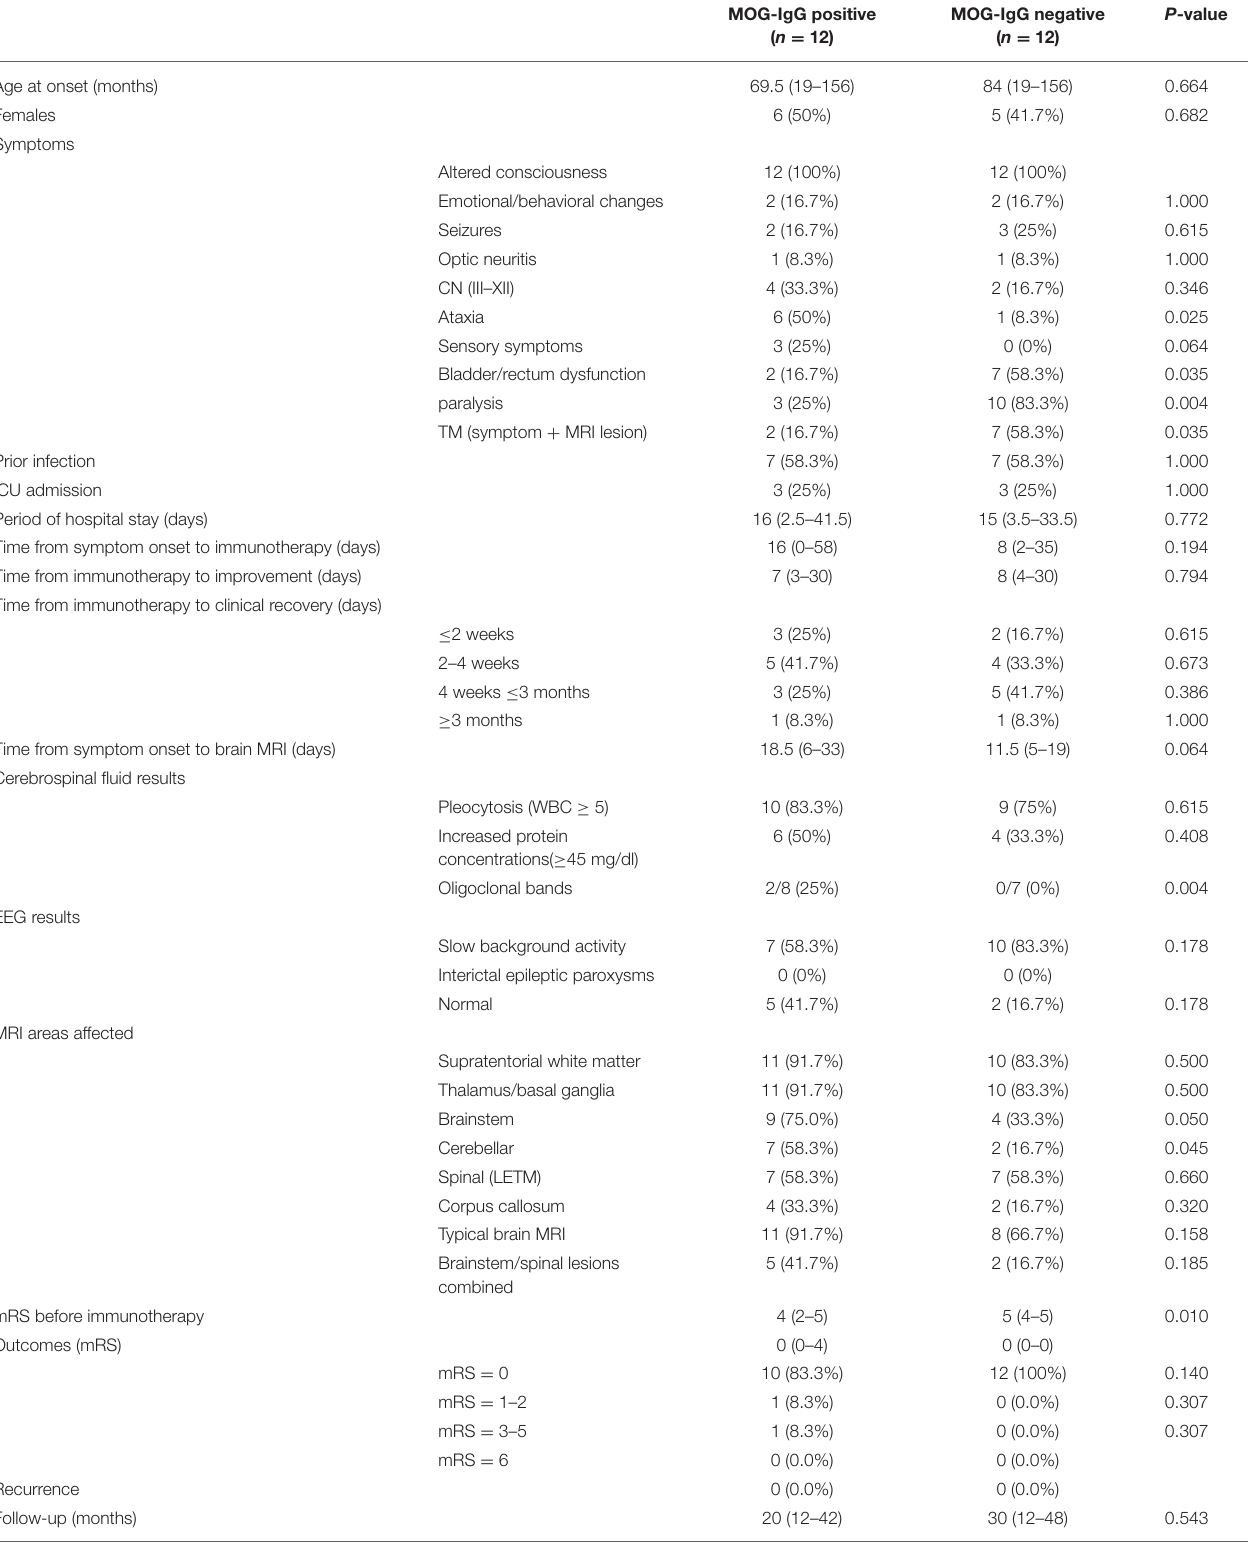
TABLE 1 | Comparison of demographic and clinical features, MRI results, and outcomes between 24 pediatric patients with ADEM with and those without